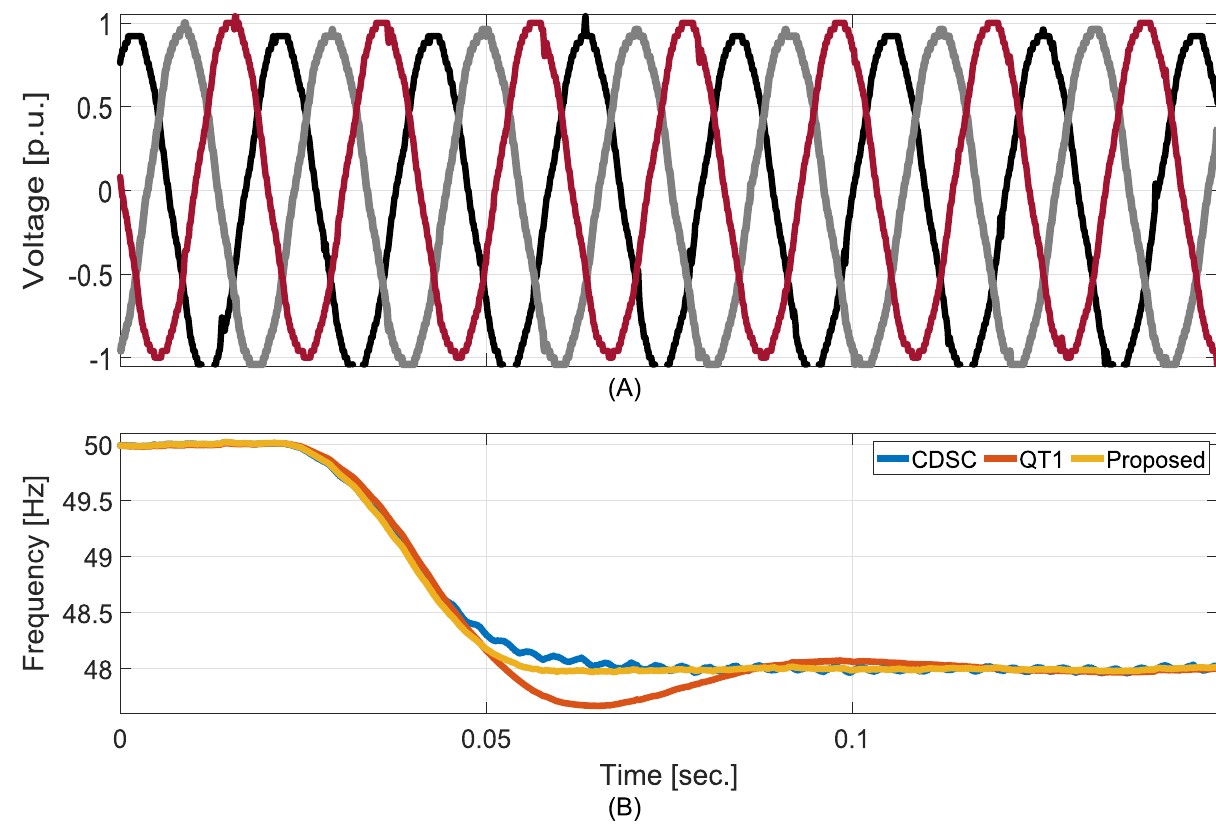
Fig 8. Comparative experimental results for − 2Hz frequency jump. A: Grid voltage. B: Estimated frequencies.